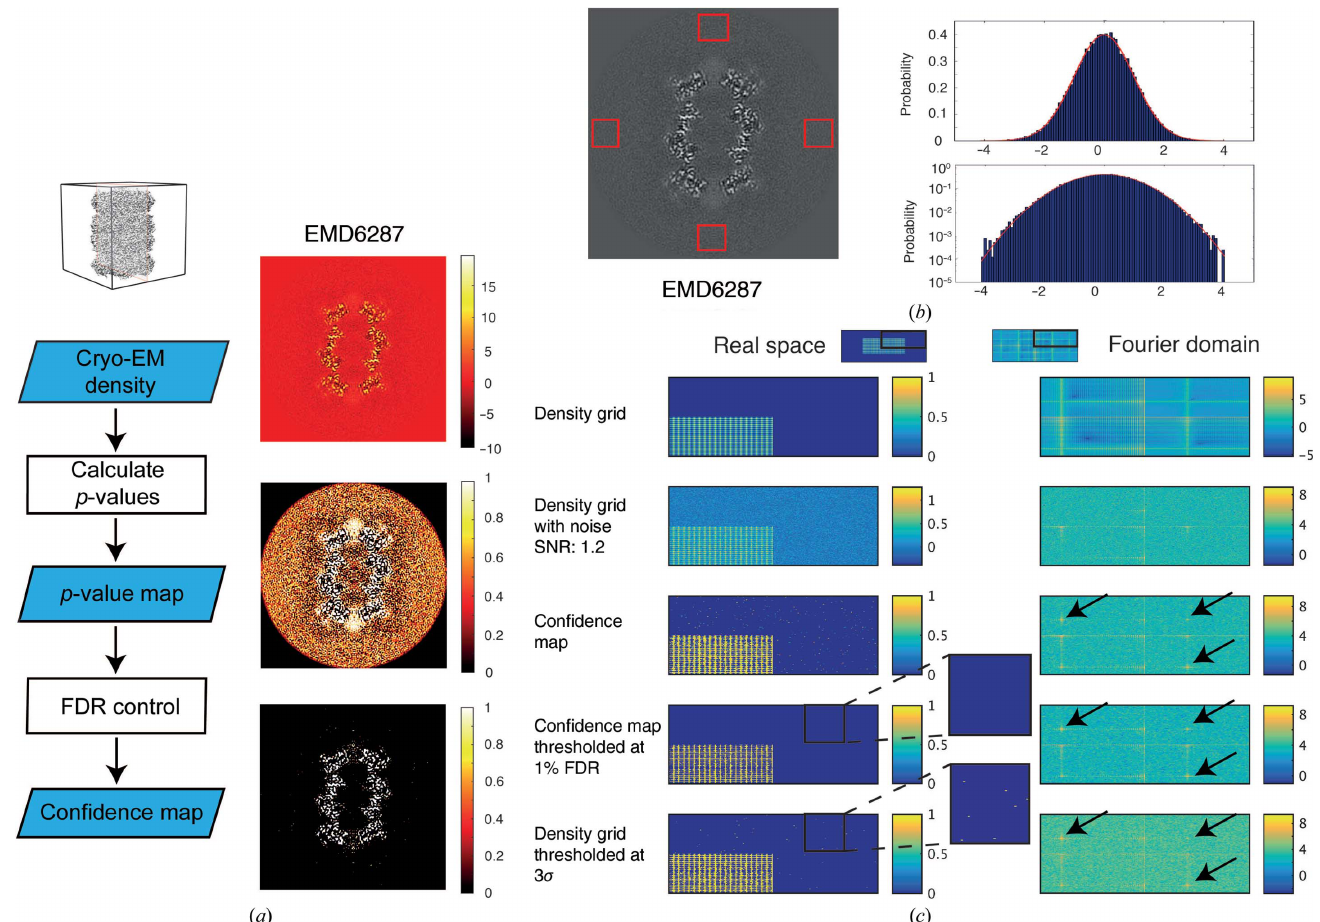
Figure 1 False discovery rate (FDR) analysis of cryo-EM maps. ( a ) Left: flowchart of confidence-map generation. The cryo-EM map is converted to p -values and finally FDR-controlled. Right: slice views through a cryo-EM map of 20S proteasome (EMD-6287) depicted at the respective stages of the algorithm (blue boxes) on the left. Note the strong increase in contrast when the sharpened map is converted to the confidence map. ( b ) Left: estimation of the background noise from windows (red) outside the particle. Right: histograms (top, probability on a linear scale; bottom, probability on a log scale) of the background window together with the probability density function of the estimated Gaussian distribution. ( c ) Evaluation of the algorithm on a simulated two-dimensional density grid. The upper right quadrant of images in real space (left column) together with the corresponding power spectrum in the Fourier domain (right column) are displayed. A density grid with added normally distributed noise at a signal-to-noise ratio of 1.2 leads to a loss of contrast at high resolution. Confidence maps recapitulate these high-resolution features (arrows), showing that high-resolution signal is detected with high sensitivity. FDR thresholding at 1% recovers a similar binary grid in comparison with 3 (cid:2) thresholding while minimizing noise contributions and minimizing detected noise (enlarged